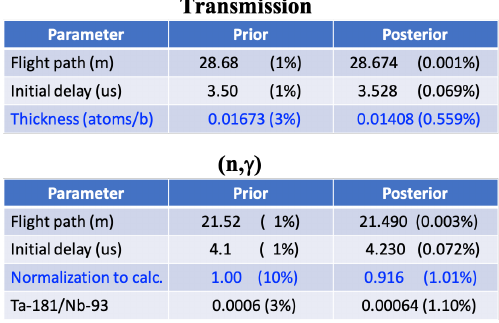
Table 1. The experimental parameter values and their uncertainties obtained in the present